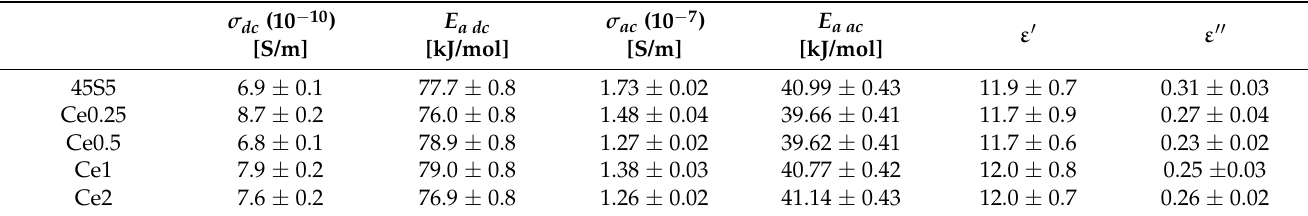
Figure 6. The logarithm of conductivity versus 1000/T, for all samples in the ( a ) dc regime and ( b ) ac regime, at 10 kHz. Table 2. Values of dc and ac conductivity and respective activation energies, and the permittivity at 10 kHz and 300 K.